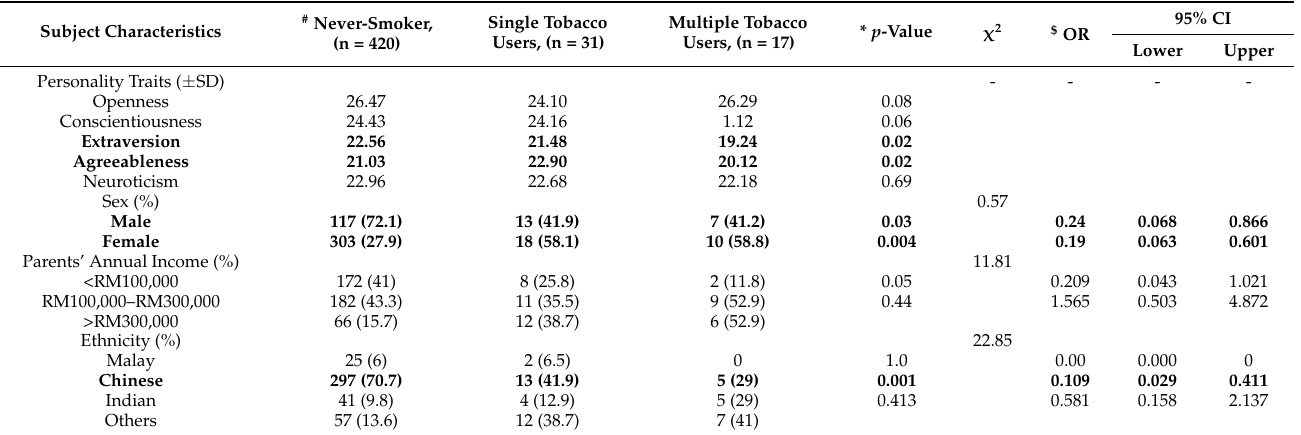
Table 3. Association between never smoker and smoker with sociodemographic factors and person- ality traits.